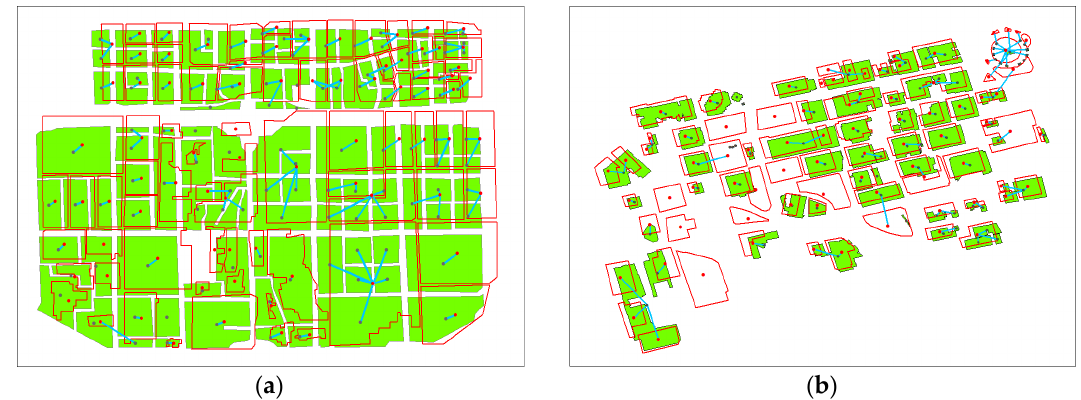
Figure 7. Matching results comparison of the mock building data: ( a ) the initial matching pairs based on local geometric similarity; ( b ) the identified matching pairs by the object ‐ level relaxation labelling method; ( c ) the identified matching pairs by the pattern ‐ level relaxation labelling method.